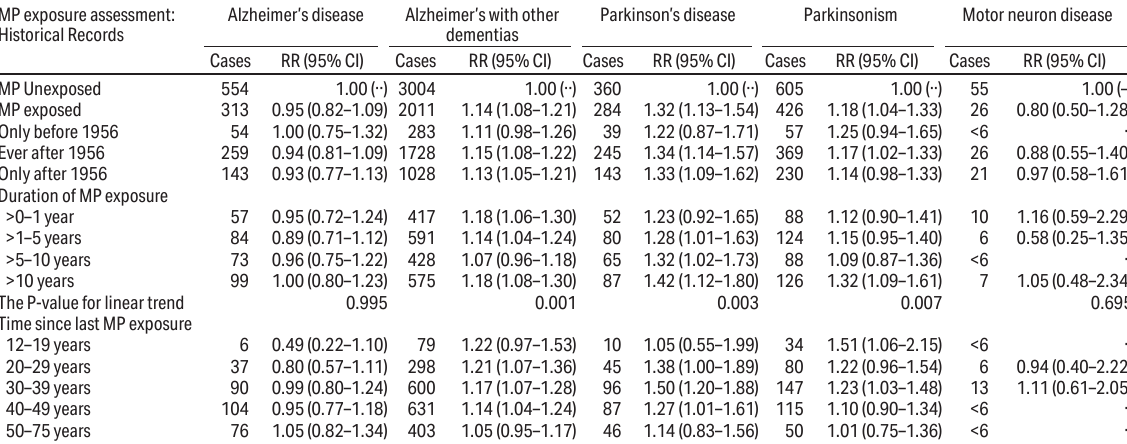
Table 4. Incidence rate ratios (RR) of neurodegenerative disease (1992-2018) by McIntyre Powder (MP) exposure assessed from historical records (periods and duration of exposure and time since last exposure) among male miners in the study cohort. [CI=95% confidence interval] a MP exposure assessment: Historical